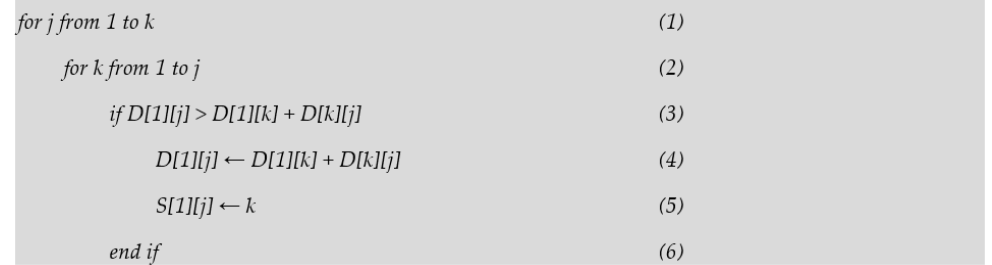
Figure 8. Floyd–Warshall pseudo ‐ code implementation for reference trajectory optimization.